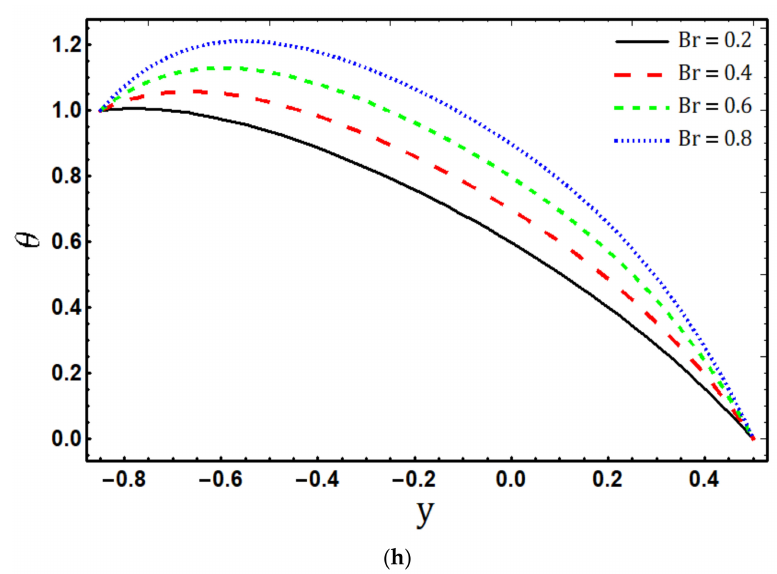
Figure 3. ( a ): Effects of m e on θ , while other parameters are b 1 = 0.3, b 2 = 0.5, x = 0.5, l =